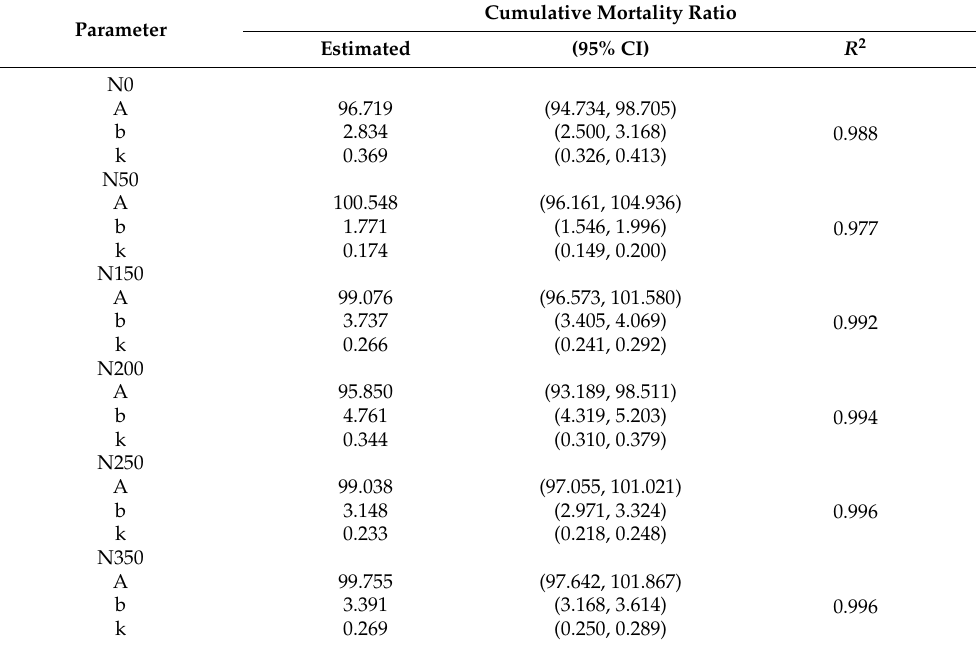
Table 3. Estimated parameters, confidence intervals, and R 2 for a logistic model of adult cumu- lative mortality fitted to experimental data of feeding S. furcifera on rice with different nitrogen fertilizer applications.